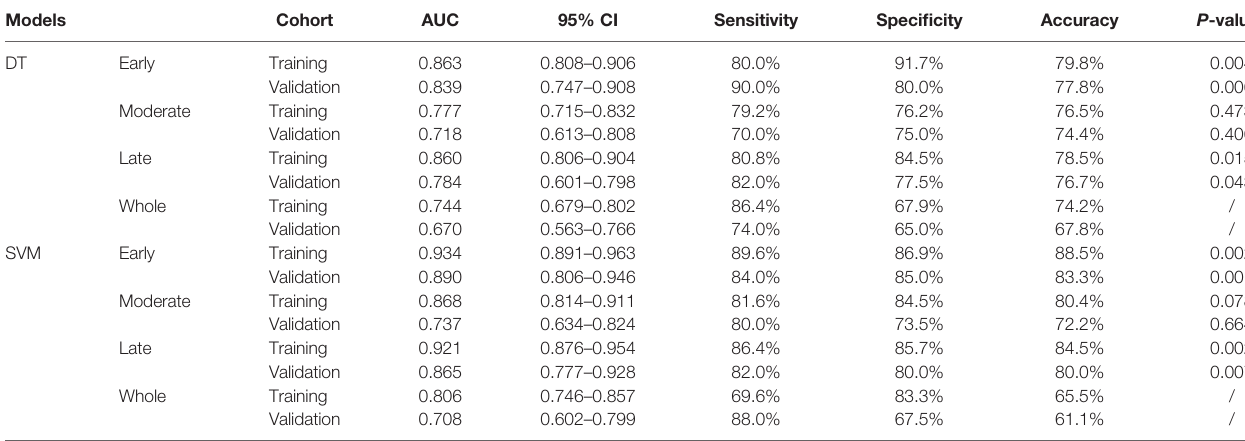
TABLE 4 | Performance of classi fi cation models for identifying benign and malignant breast tumors.